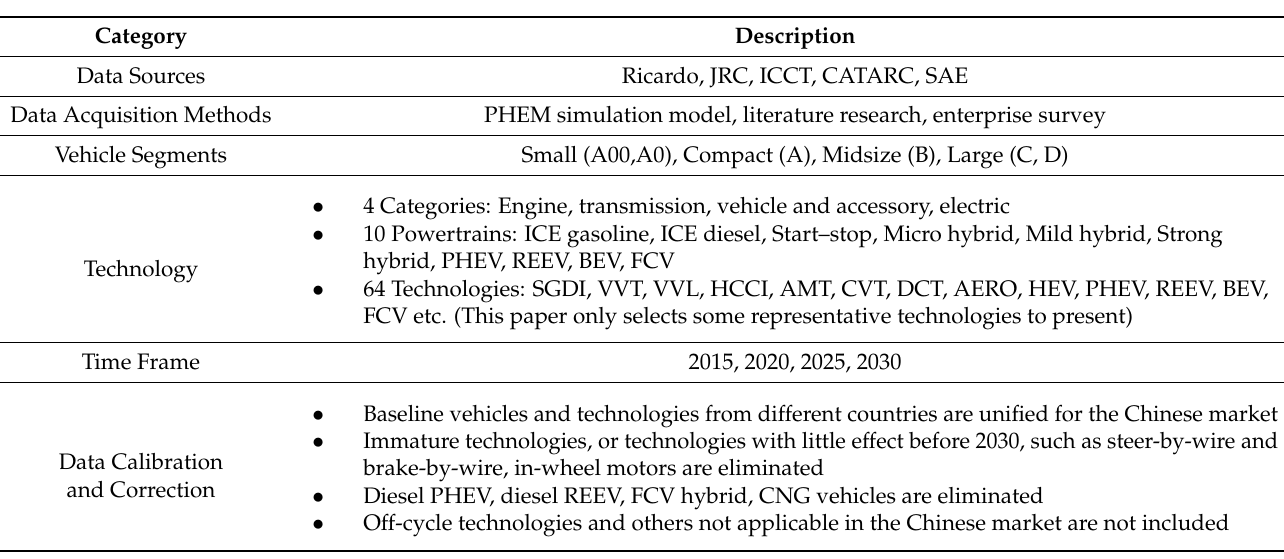
Table 2. Data and parameters specification.